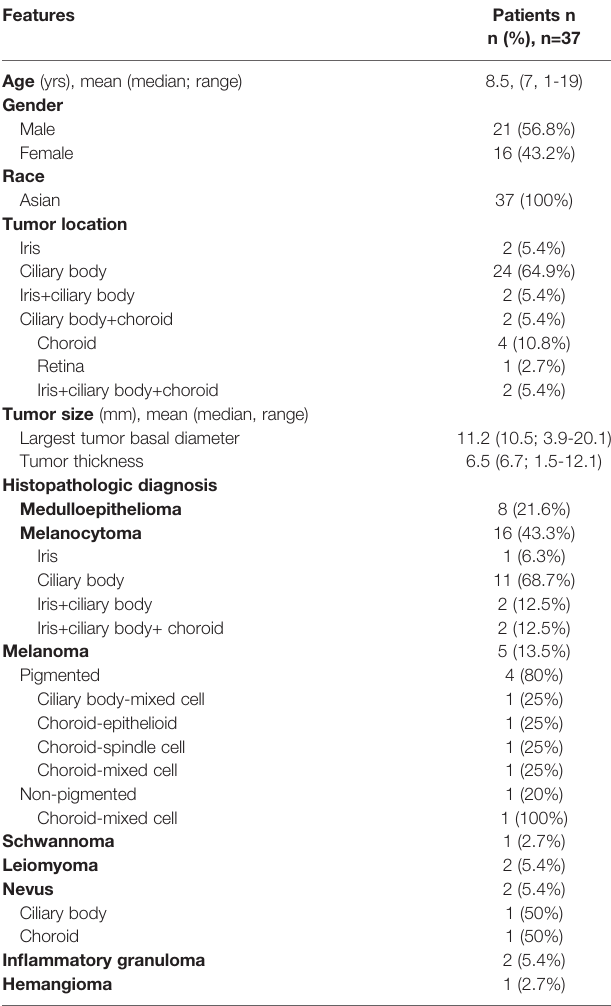
TABLE 1A | Surgical Resection (Partial Transscleral Sclerouvectomy Combine with Mircoinvasive Vitrectomy and Reconstruction of the Eyeball) of Intraocular Tumors in 37 Children: Demographic and Clinical